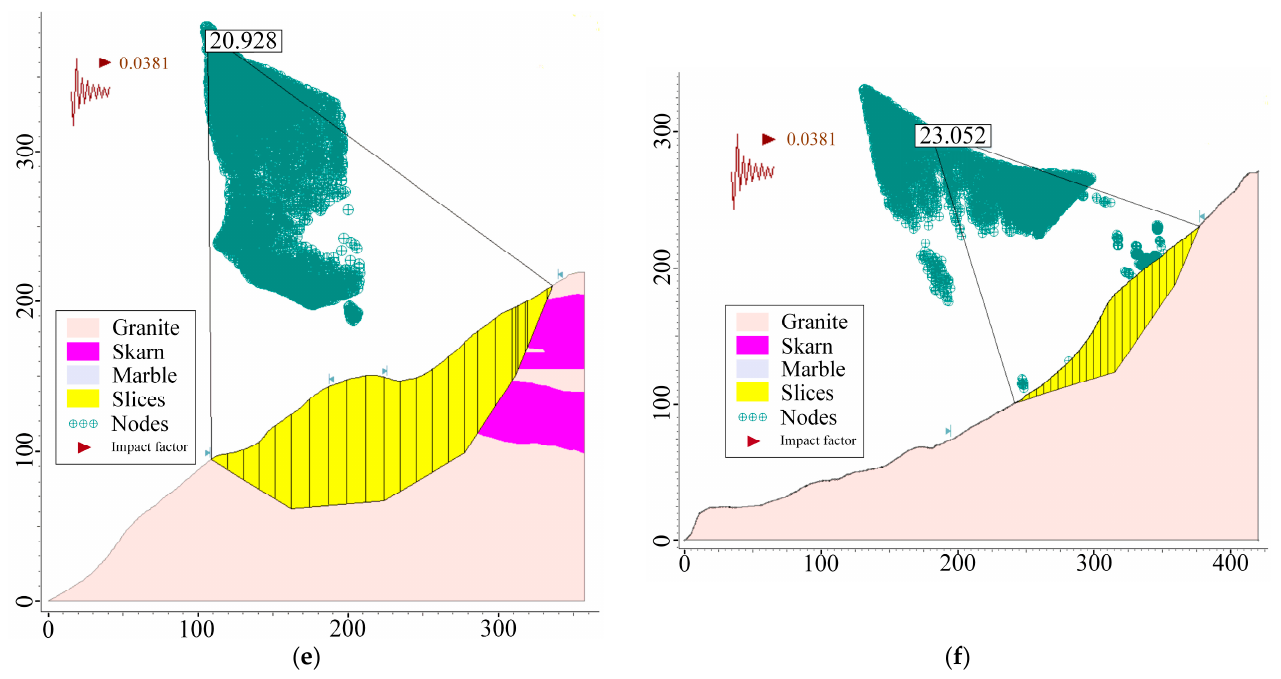
Figure 8. Calculation results of the limit equilibrium method (self ‐ weight + blasting): ( a ) R1; ( b ) R3;